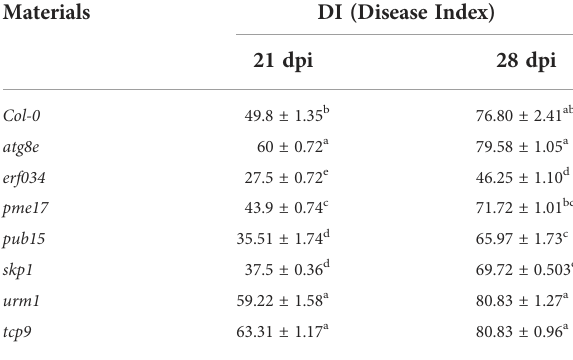
TABLE 4 Results of disease investigation of A. thaliana inoculated with P. brassicae .